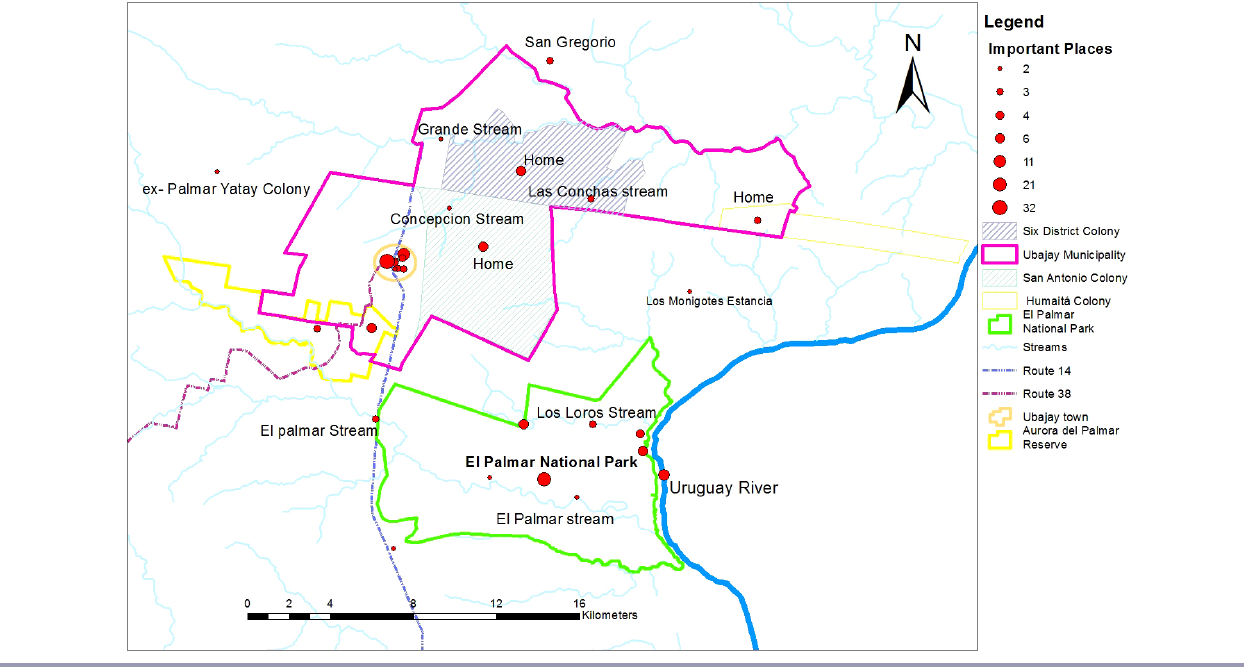
Fig. 2 . Places most frequently mentioned as being important near the Municipality of